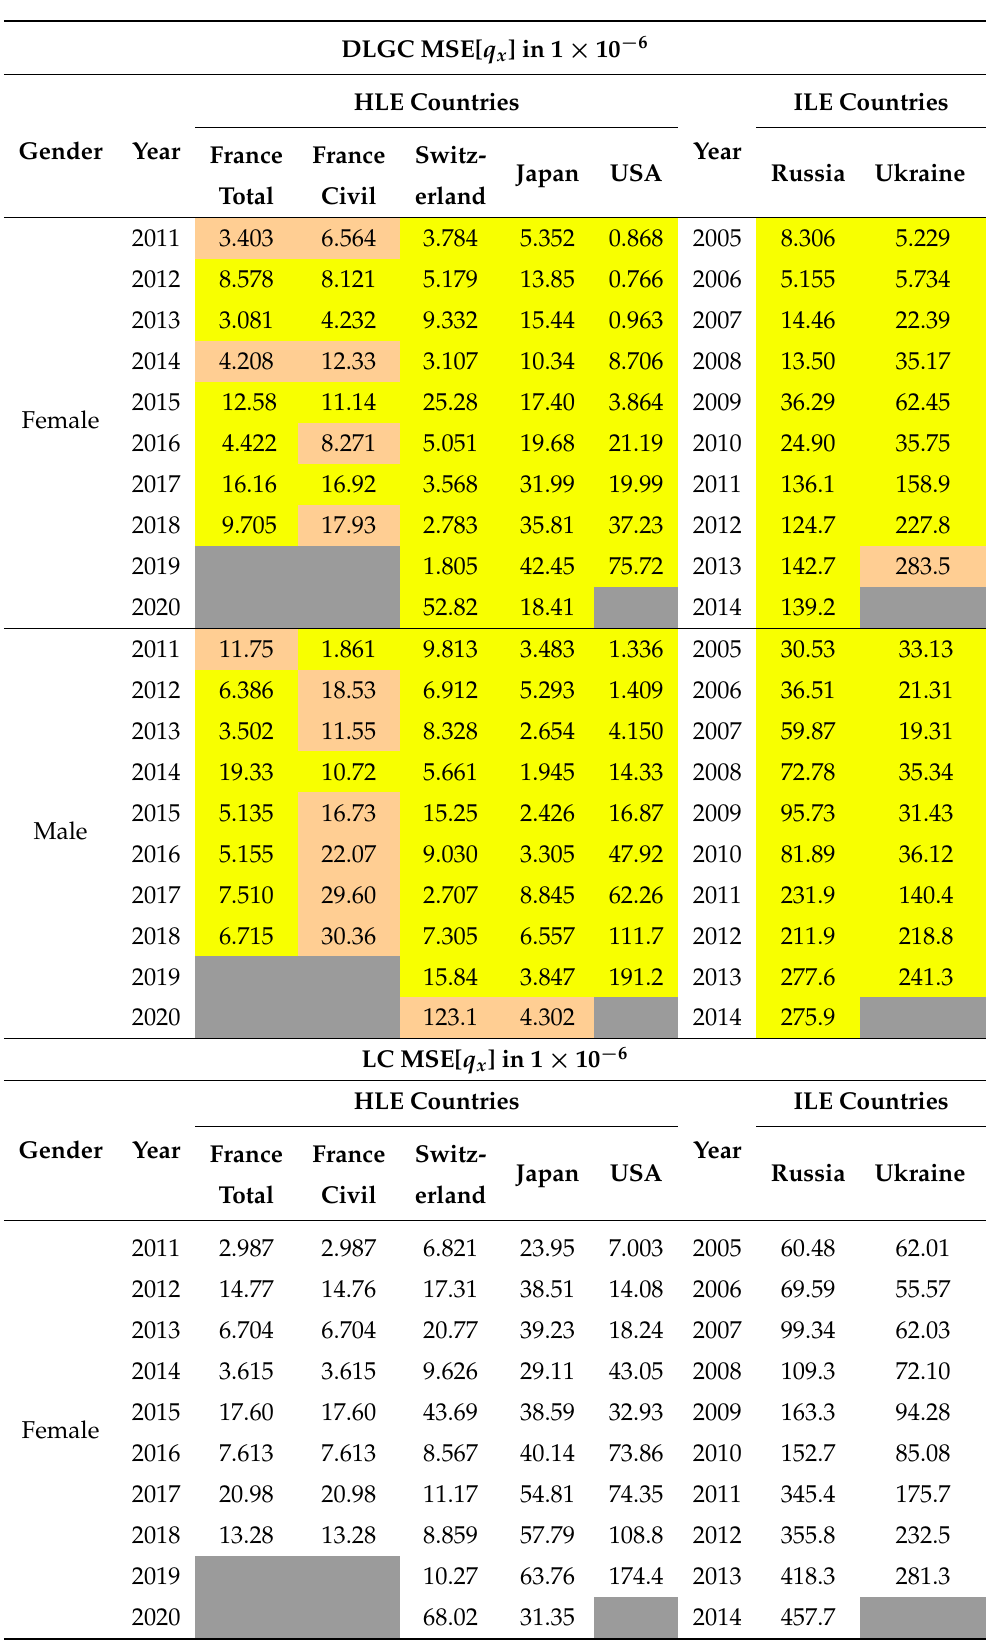
Table 4. Comparing 10-year-ahead forecasts’ MSE[ q x ] of the logit-binomial Lee–Carter model and